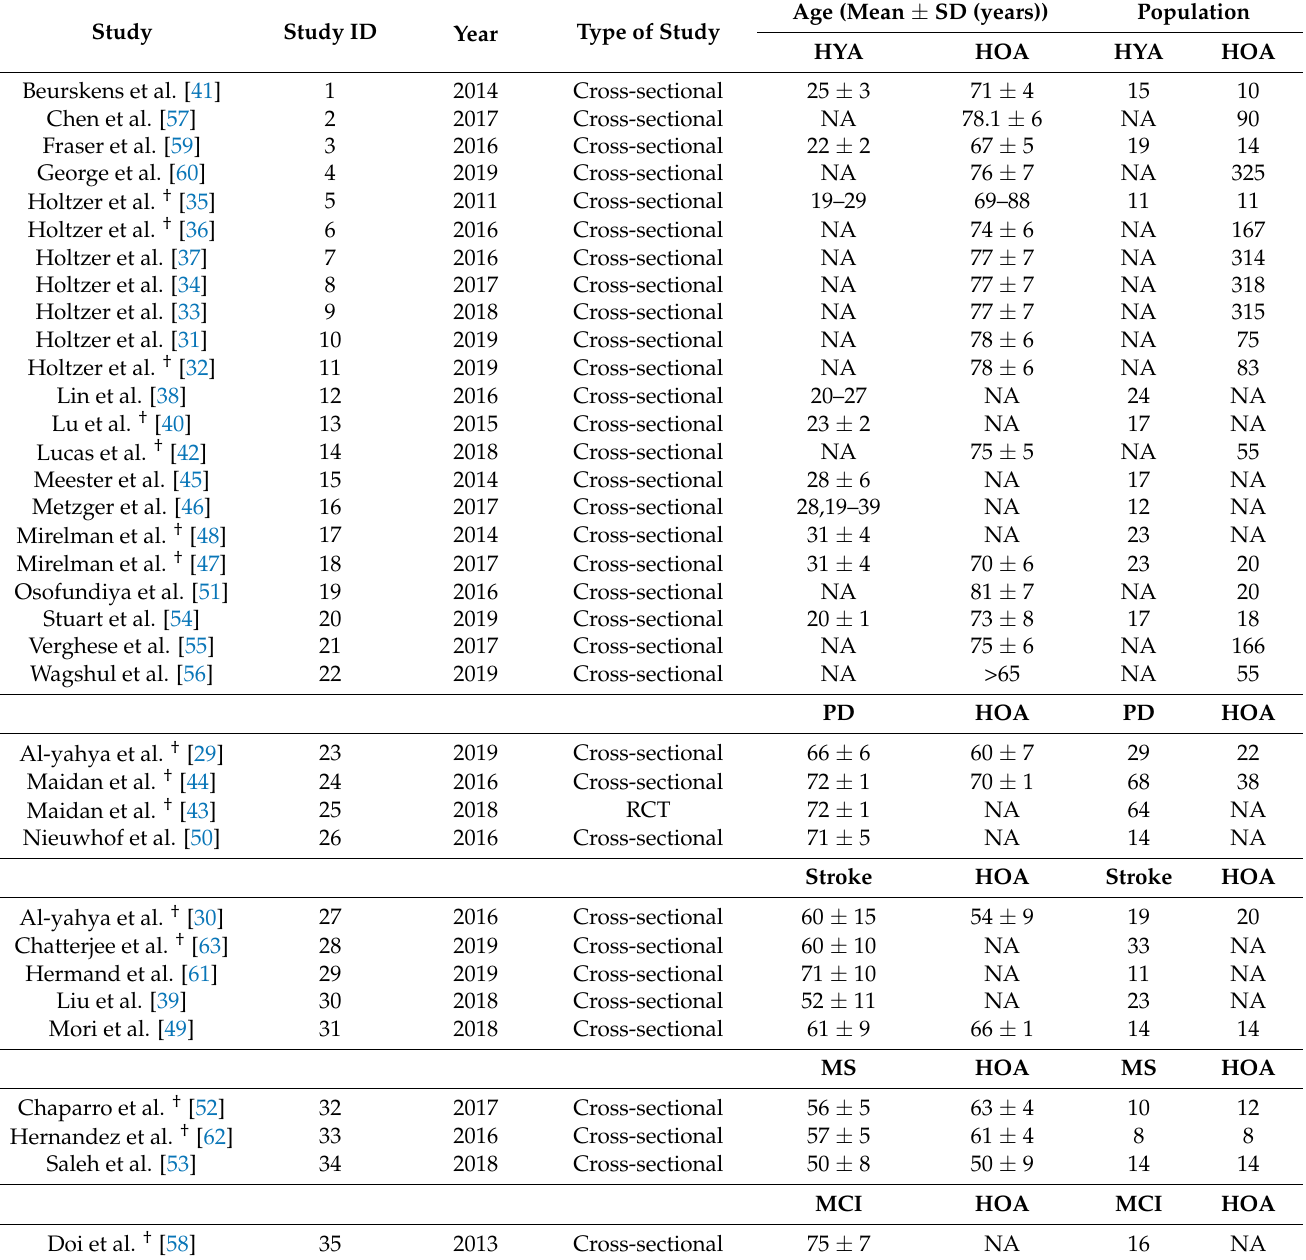
Table 1. Study and Participant